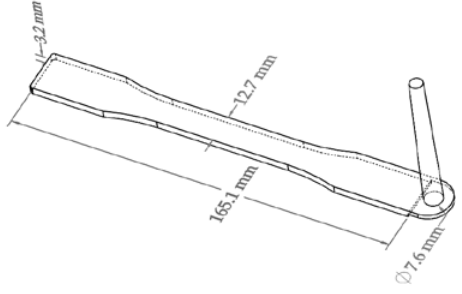
Figure 1. Schematic of the injection-molded specimen ASTM D638 Type I tensile bar mold cavity with its sprue.